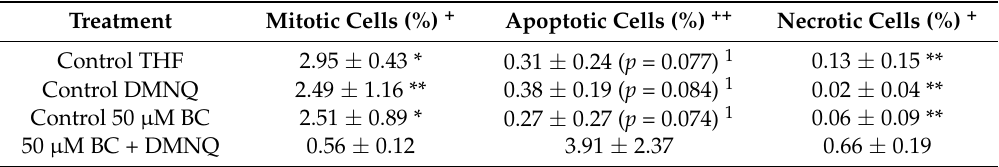
Table 1. Effects of β -carotene in the presence of DMNQ on mitotics, necrotic, and apoptotic cells in primary rat pneumocyte type II cells.